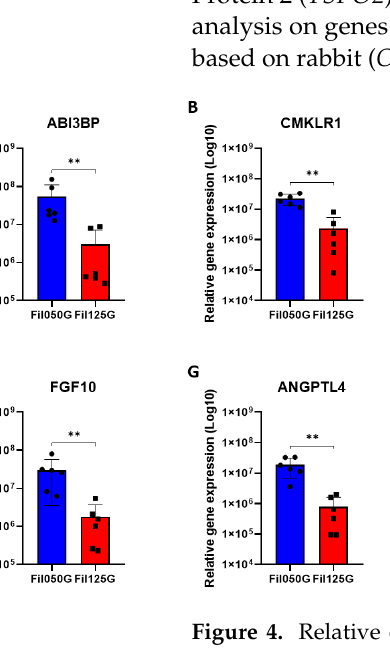
Figure 4. Relative expression of genes overrepresented with GO enrichment analysis in ( A – G )